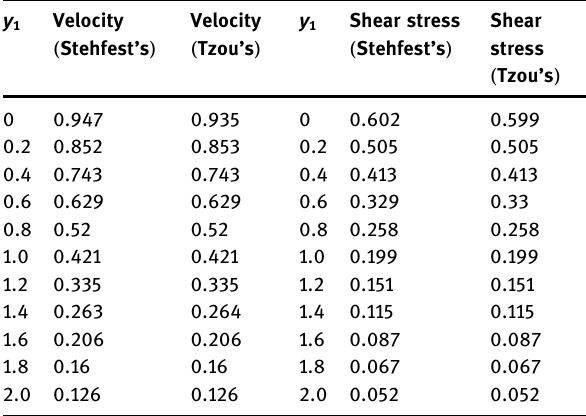
Table 1: Comparison of velocity and shear stress with two di ff erent “ numerical algorithms, i.e. , Stehfest ’ s and Tzou ’ s ” at α